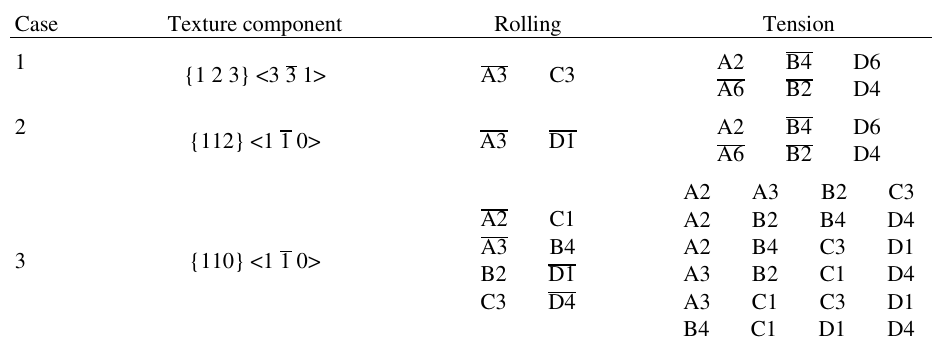
Table 1. Sets of active slip systems according to the Taylor model in rolling and tension (normal to rolling), for three different grain orientations corresponding to the main texture